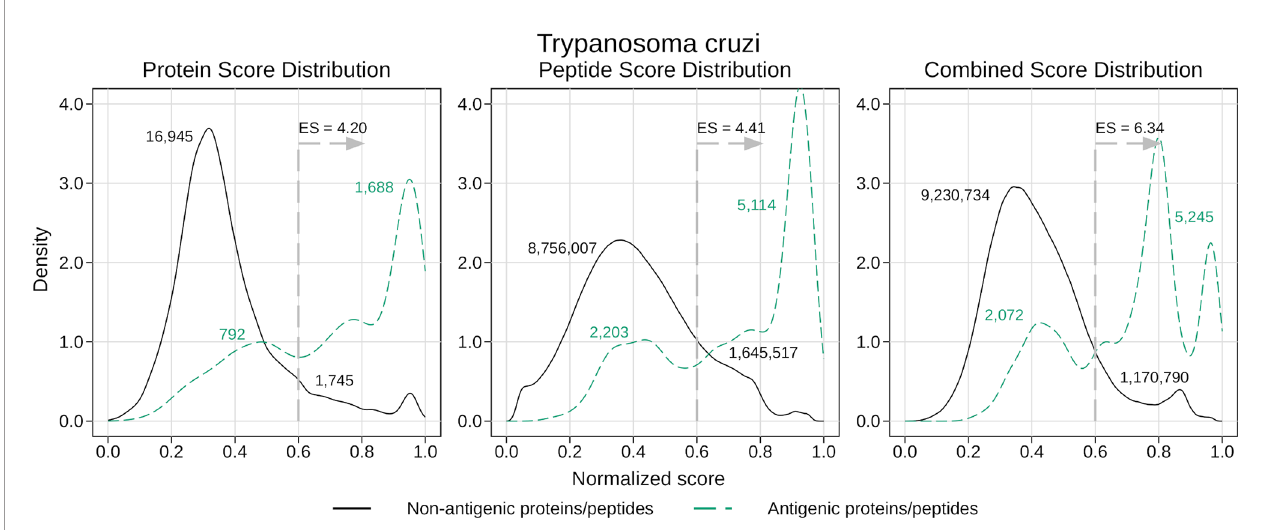
FIGURE 4 | Density analysis for the antigenicity scores of T. cruzi . Plots were obtained by analyzing the proteome of T. cruzi with the leave-one-out generic models, and then distinguishing between antigens and non-antigens. The fi gure shows the enrichment score obtained by keeping only the proteins and peptides with a score greater than 0.6, as well as the amount of antigens and non-antigens that would be inside or outside that